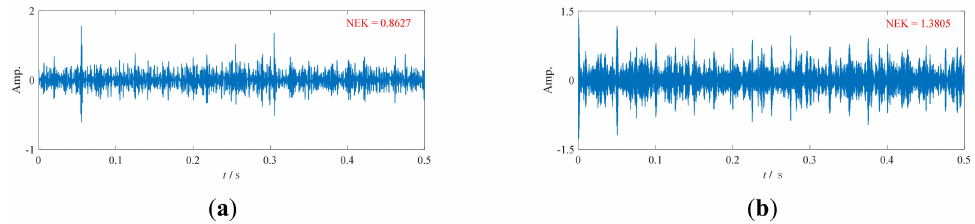
Figure 5. Results by RVMD for the simulation signal: ( a ) IMF1 and ( b )